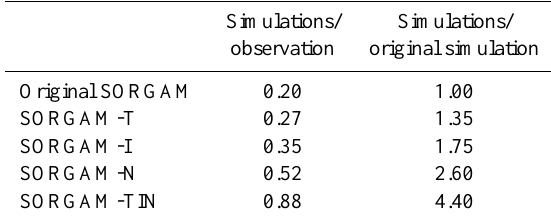
Table 5. The performance of adjusted